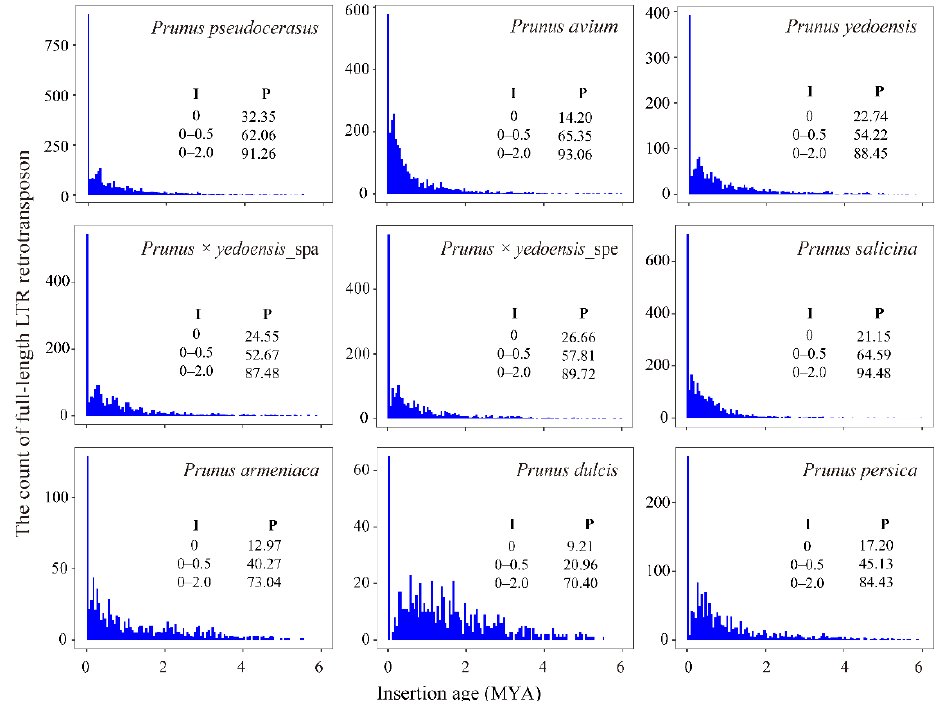
Figure 2. Distribution of the insertion ages of LTR-RTs. I represents insertion age; P represents the percentage (%). Insertion time was split into bins of 0.05 MYA.